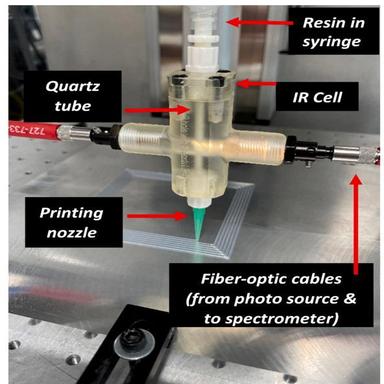
Flow though IR cell, BuildTak not shown.